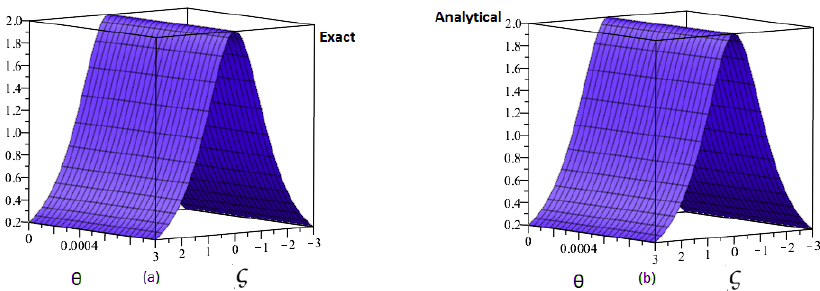
Figure 4. The profile of both exact solution ( a ) and obtained solution ( b ) are